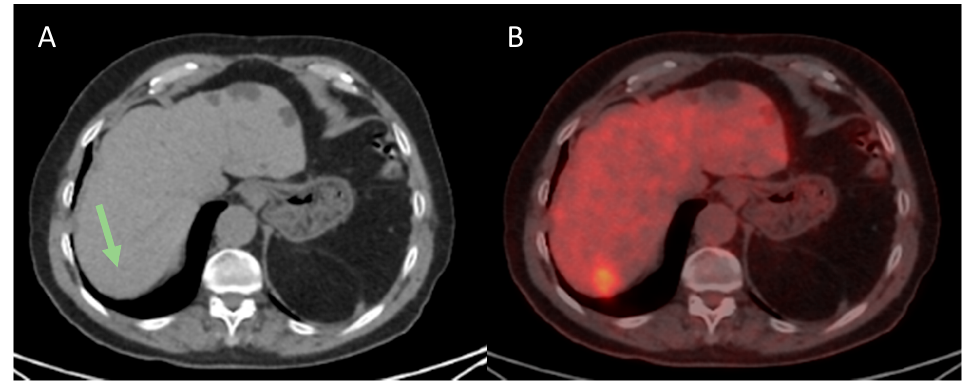
Figure 1. Hepatocellular carcinoma (HCC) of 33 mm, difficult to identify in the non-contrast enhanced CT (( A ), green arrow) but with a high FDG uptake ( B ), with SULpeak60 of 3.98 and TLRpeak60 of 1.91. The resection specimen showed a grade 3 HCC with microvascular invasion (MVI). The disease recurred seven months after surgery.